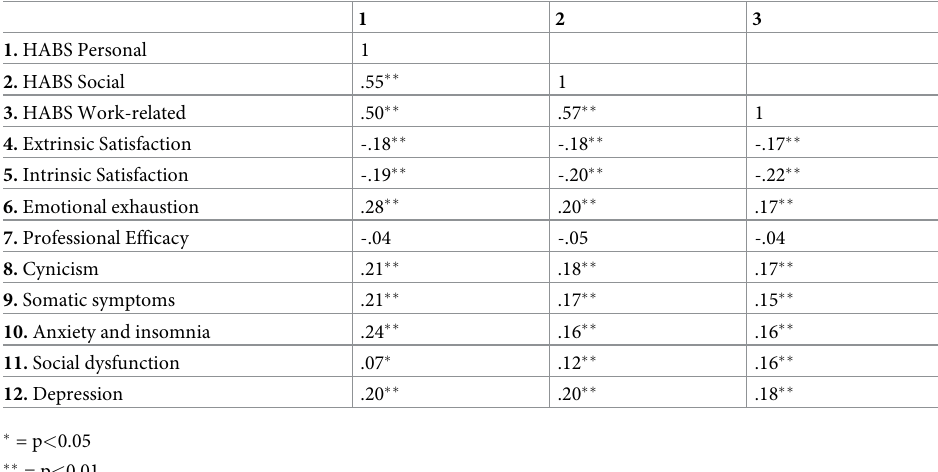
Table 2. Correlations between social lateral violence and possible consequences in health professionals.